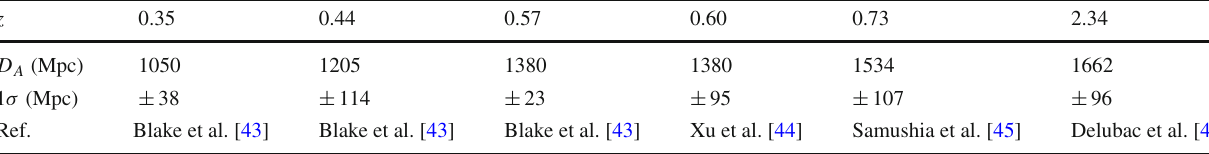
Table 1 The currently available angular diameter distance data from BAO and their